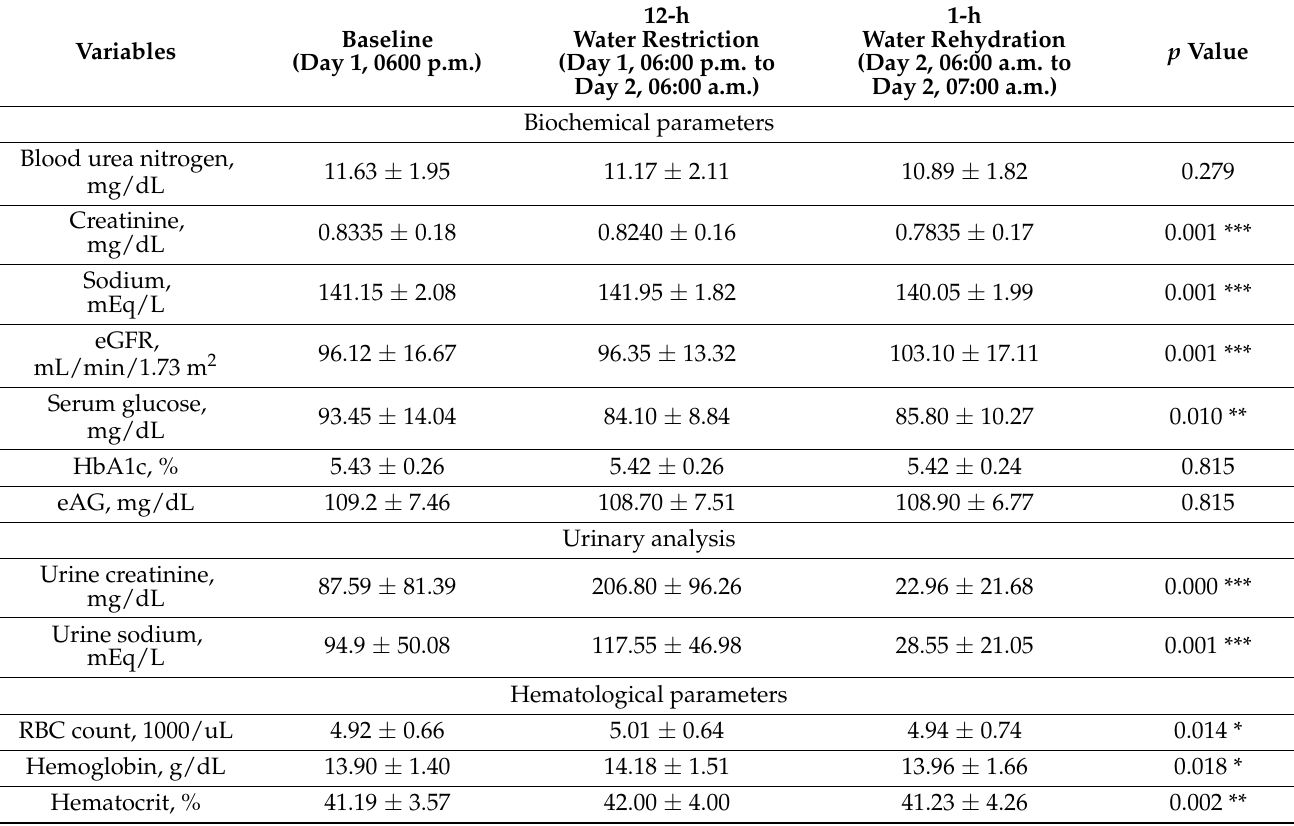
Table 2. Laboratory findings in the different groups (normal status, water restriction, and rehydration status). Baseline Variables (Day 1, 0600